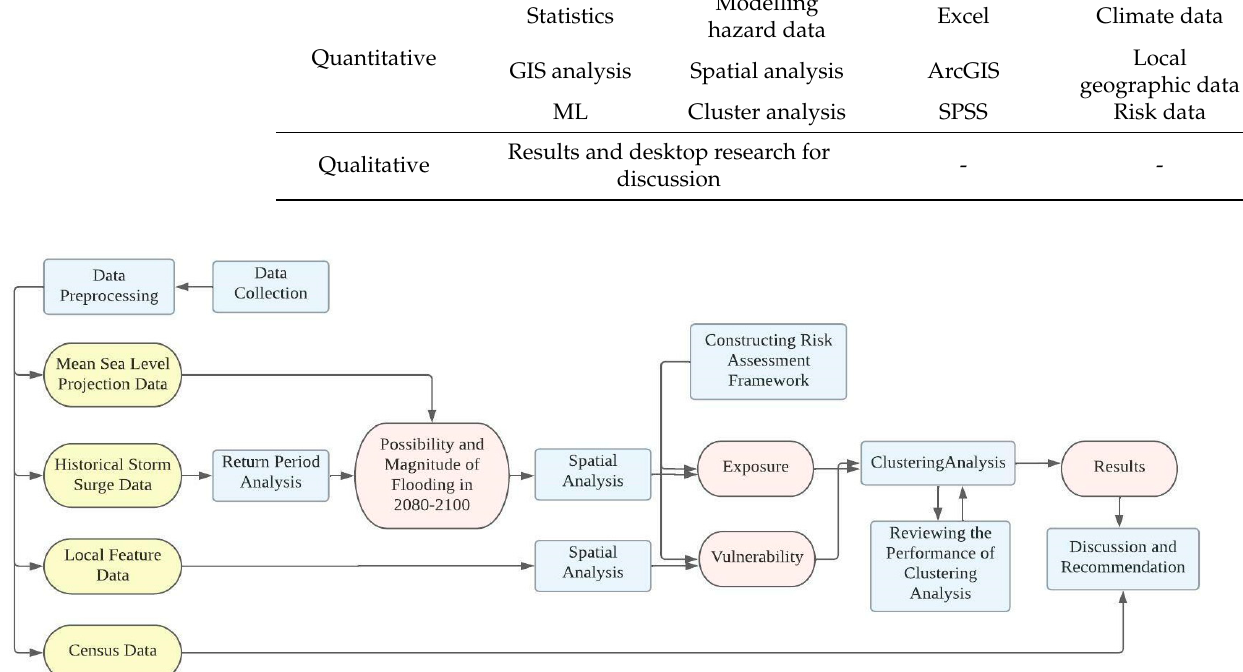
Table 2. Research approach for this study.